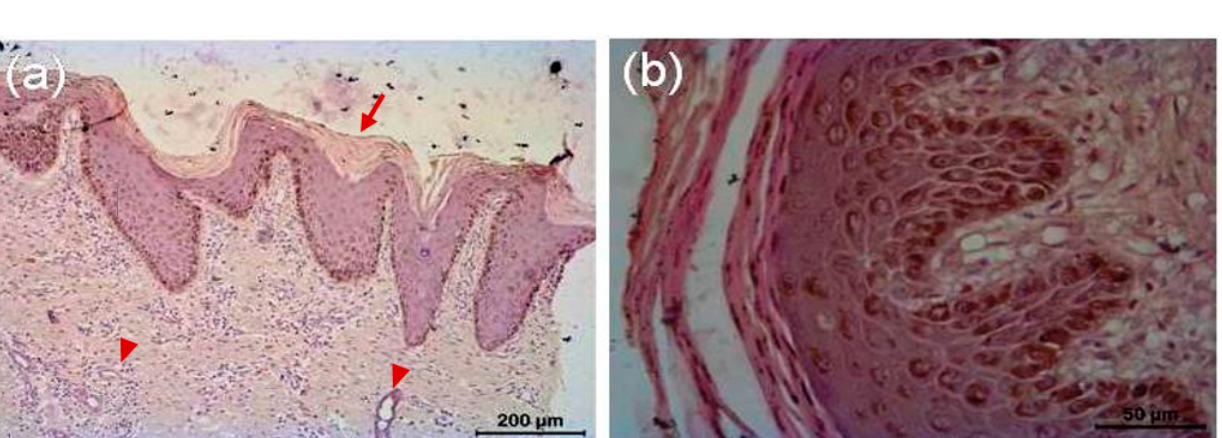
Figure 6. Histopathology of skin of affected animal ( a ) Microfilarial organisms (arrow) are beneath the epidermis and are surrounded by some fibrocytes (arrow head) and infiltrated cells followed by squamous epithelial cells; ( b ) microscopic lesion of parakeratotic hyperkeratosis (thickening of Stratum corneum of the epidermis) (arrow); keratinocytes are nucleated, and Stratum spinosum and Stratum granulosum both are proliferated. Rete pegs are elongated and hyperplastic, which led to acanthosis (arrow head); ( c ) infiltrations of polymorphonuclear cells (eosinophils) along with some monomorphonuclear cells (arrow head). Infiltrated cell forms microabscess containing debris within (arrow); ( d ) Dermis shows extensive reaction that caused dermatitis and extensive infiltration of eosinophil and neutrophil along with lymphocytes, and eosinophilic granules (arrow) are also present in the dermis area; ( e ) severe infiltration of inflammatory cells in the Stratum corneum and Stratum spinosum (arrow). Keratinocytes retain nucleolus, highly proliferative in nature (arrow head). Cells of Stratum spinosum also show proliferation and contain microfilarial organism. There are exudates within epidermis between two layers. Microcavities filled with tissue debris, and inflammatory cells are observed.